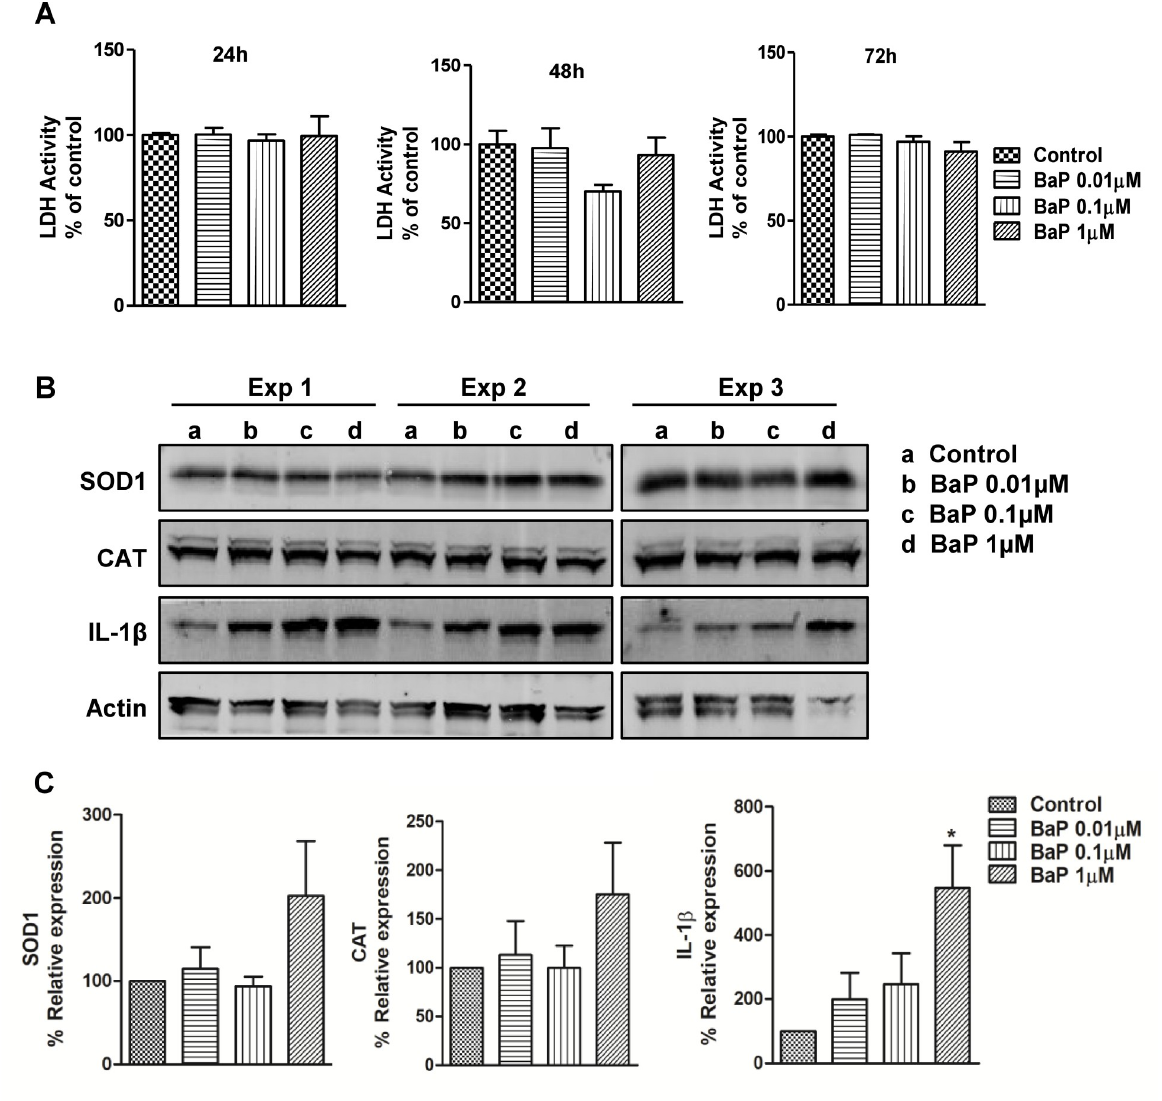
Fig 4. LDH activity and protein expression of AOEs and cytokine IL-1 β (A, B). (A) LDH activity was performed in SVGA cells treated with different concentrations of BaP (daily treatment up to 72 h). (B) Representative Western blots of AOEs (SOD1 and CAT) and IL-1 β in SVGA cells (Western blot at 72 h) treated with different concentrations of BaP (daily treatment up to day 3). Untreated controls were considered as 100% in the densitometry analysis. (C) Densitometry analysis. Statistical analyses were carried out by using one-way ANOVA. Results are expressed as means ± S.E.M of n = 4 experiments. � P � 0.05, in comparison with untreated control. BaP treatment at 24 h (P � 0.001; Student’s t-test; Fig 5A), 48 h (P � 0.001; Student’s t-test; Fig 5A) and 72 h (P � 0.001; Student’s t-test; Fig 5A). Whereas SOD1 and CAT mRNA expression was found to have notably increased at 24 h (P � 0.01; Student’s t-test; Fig 5A) only. However, CYP2A6 mRNA expression was not altered at any time point after the BaP treatment. Next, the protein expression of IL-1 β , AOEs, and CYP enzymes was measured in SVGA cells treated with BaP (1 μ M) at 24, 48, and 72 h (Fig 5B and 5C). IL-1 β protein expression was significantly increased in SVGA cells at 48 h ( P � 0.01; Student’s t-test; Fig 5B and 5C, S3 Fig) and 72 h ( P � 0.01; Student’s t-test; Fig 5B and 5C, S3 Fig) post-BaP treatment when compared to untreated